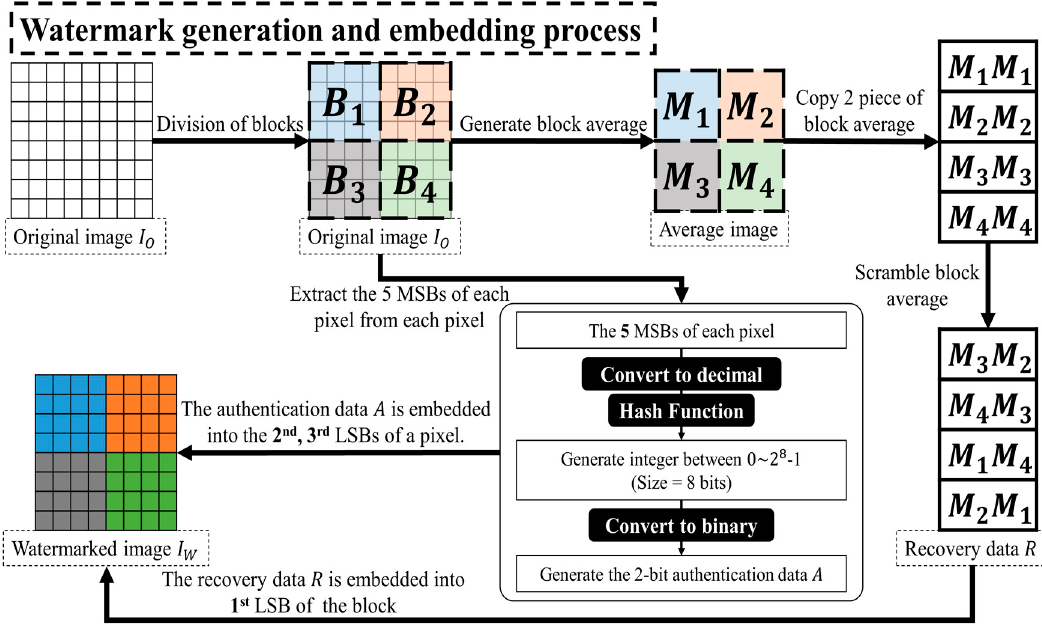
Figure 3. Flowchart of the watermark generation and embedding process based on “pixel-wise detection”.